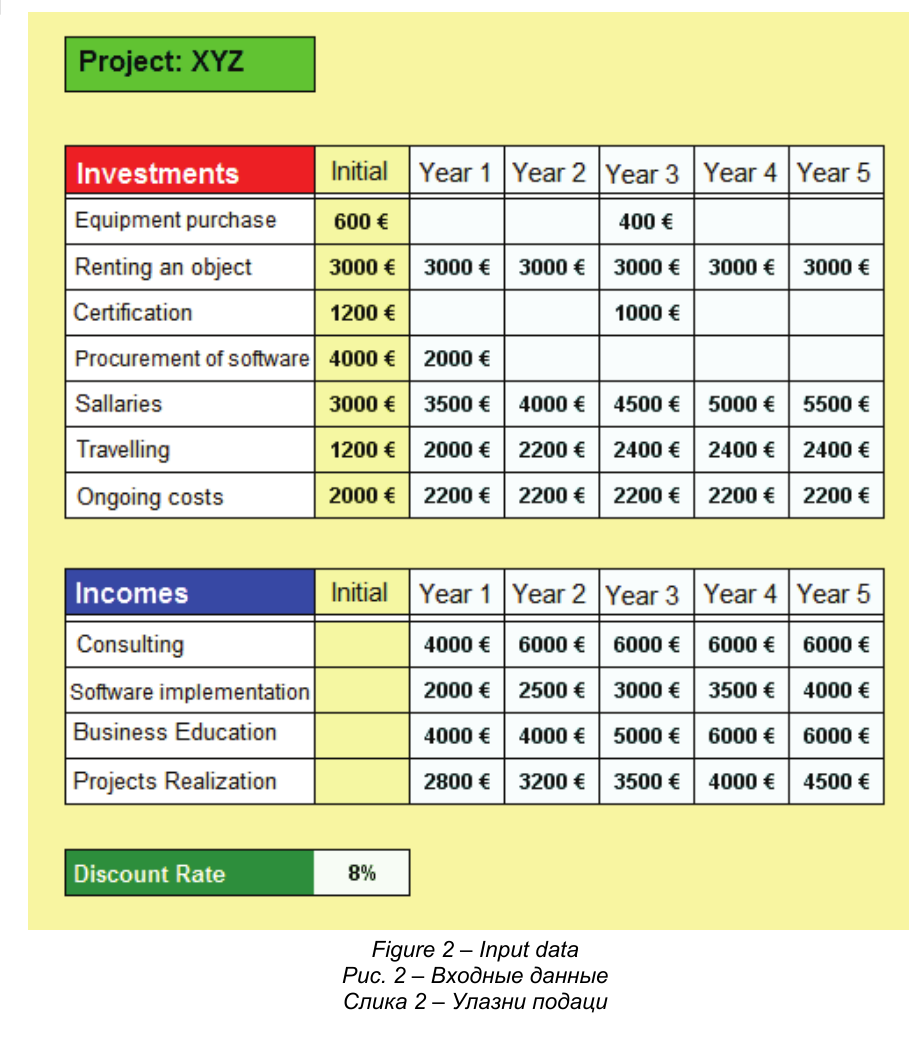
Figure 2 – Input data Рис . 2 – Входные